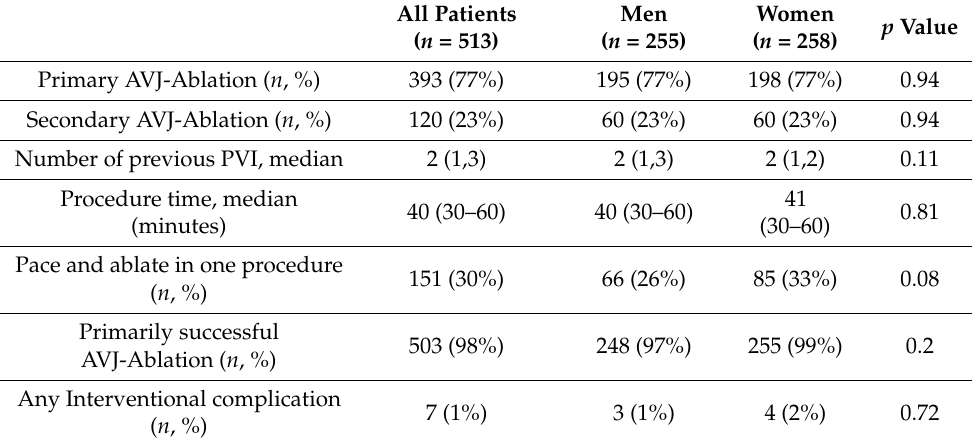
Table 2. Procedural